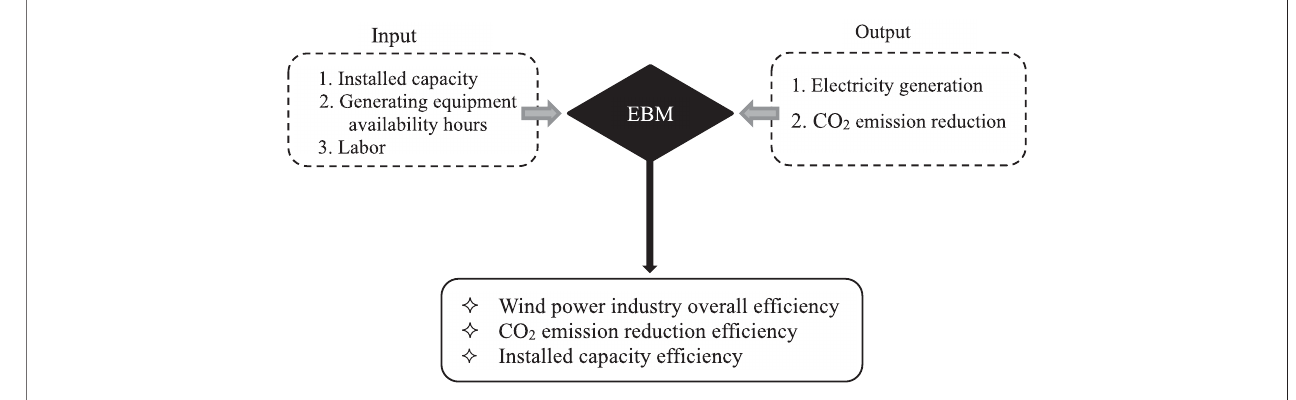
FIGURE 1 | Research framework